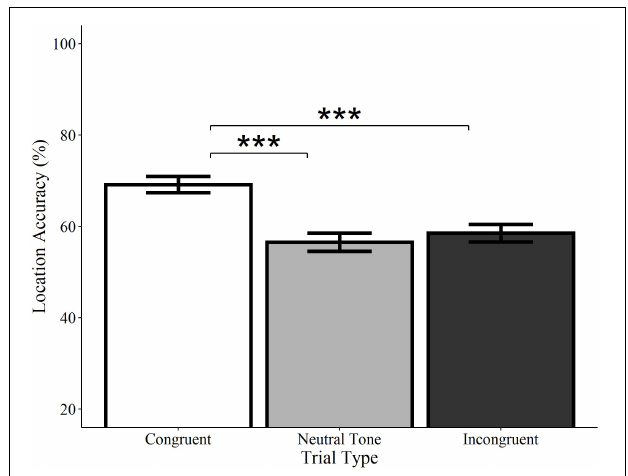
FIGURE 7 | Effect of trial type on location accuracy for environmental sounds. Locations of visual objects initially paired with congruent (white) environmental sounds were remembered with significantly greater accuracy than those paired with neutral (gray) or incongruent (black) sounds. Neutral and incongruent trials did not significantly differ from each other. Error bars represent standard error. *** p <